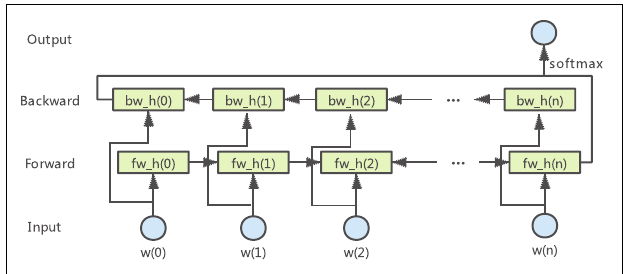
FIGURE 1 | The architecture of bidirectional